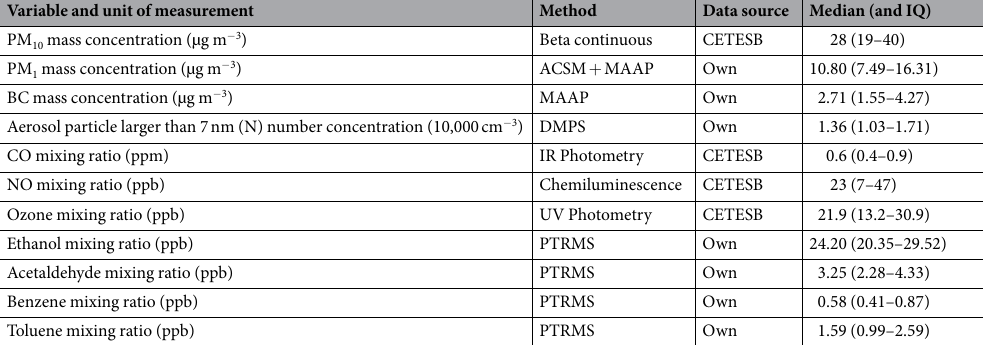
Table 1. Description of the different data sets used in this study and summary statistics. Measurement data has been averaged into 1-h bins, resulting in 741 valid data points from 08 February to 08 April 2013.